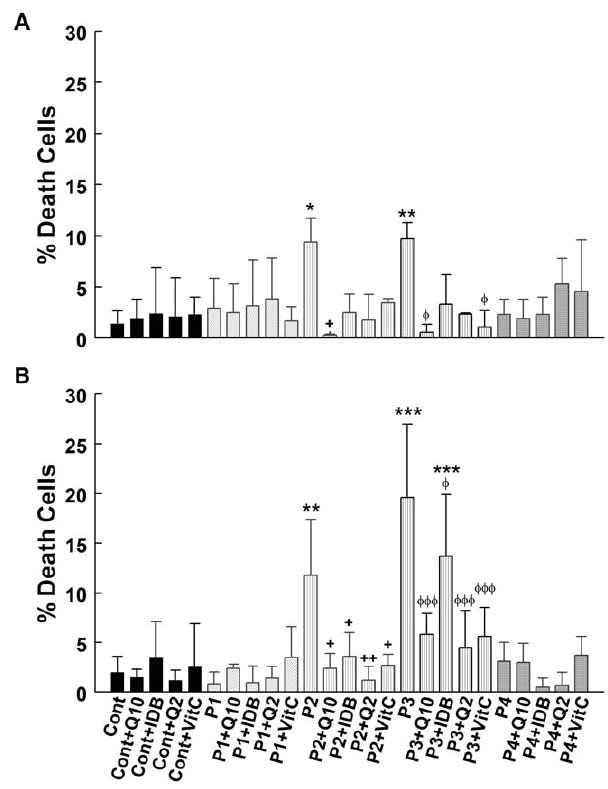
Figure 5. Superoxide anion production in cells treated with antioxidant compounds for 24 hours (A) or 1 week (B). Cultured skin fibroblasts from controls and CoQ 10 deficient patients were treated with 5 m M CoQ 10 , idebenone, CoQ 2 , or vitamin C. After 24 h ( A ) or 1 week ( B ), fibroblasts were collected and superoxide anion generation was assessed by MitoSOX staining and quantified by flow cytometry The Y axis represents the fluorescence intensity of the sample relative to the fluorescence intensity of the control sample (F P /F C ), after subtracting the background intensity; the X axis represent the sample. 20,000 cells were analyzed in every experiment. Results are expressed as mean 6 SD of three experiments. P1= COQ9 mutant; P2= COQ2 mutant; P3= COQ2 mutant; P4= PDSS2 mutant. *** P , 0.001 compared with untreated control; ## P , 0.01 and ### P , 0.001 compared with untreated P1; +++ P , 0.001 compared with untreated P2; ww P , 0.01 and www P , 0.001 compared with untreated P3.